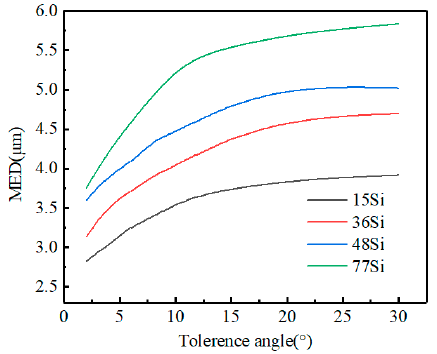
Figure 7. MED depicted as a function of the tolerance angle. Table 3. Microstructure observations.